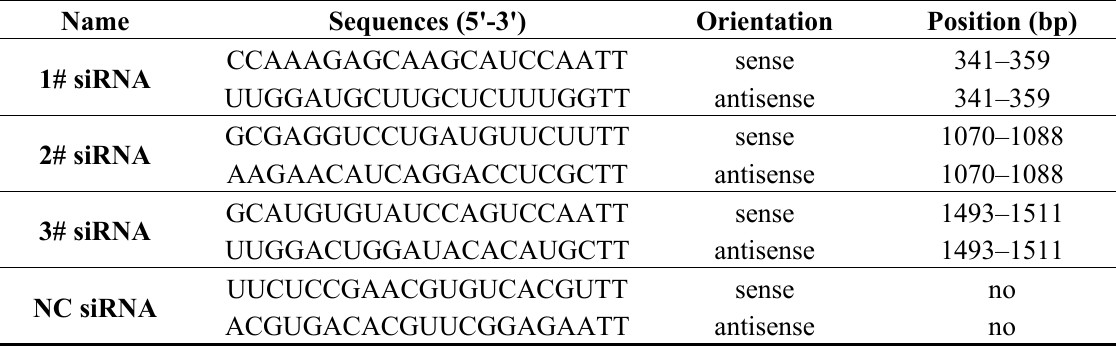
Table 2. The sequences of siRNA targeting CSGalNAcT2